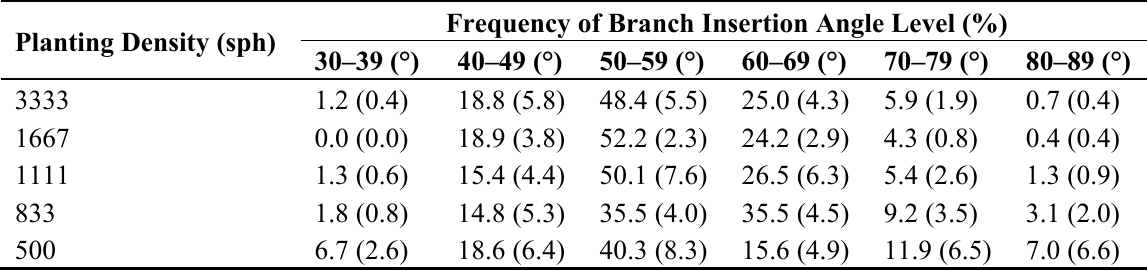
Table 4. Frequency distribution of insertion angle of occluded branches for Betula alnoides. Planting Density